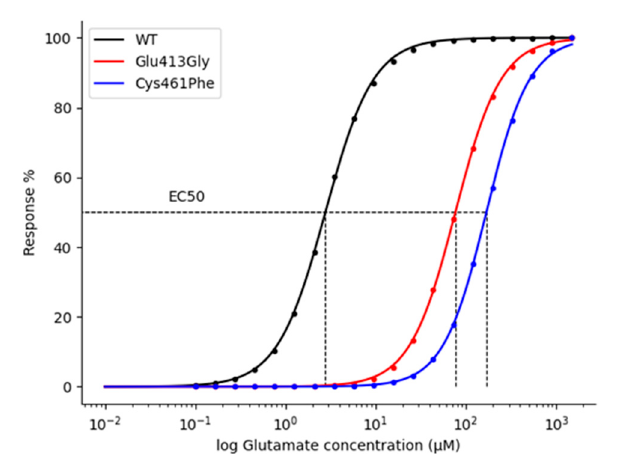
Figure 10. Dose-response curves of the effect of glutamate on wild-type (WT) and variant-NMDA receptors. Simulation data was fitted with logistic regression. EC 50 values of 2.7, 76, and 169 µM for WT, Glu413Gly, and Cys461Phe-NMDA receptors, respectively.